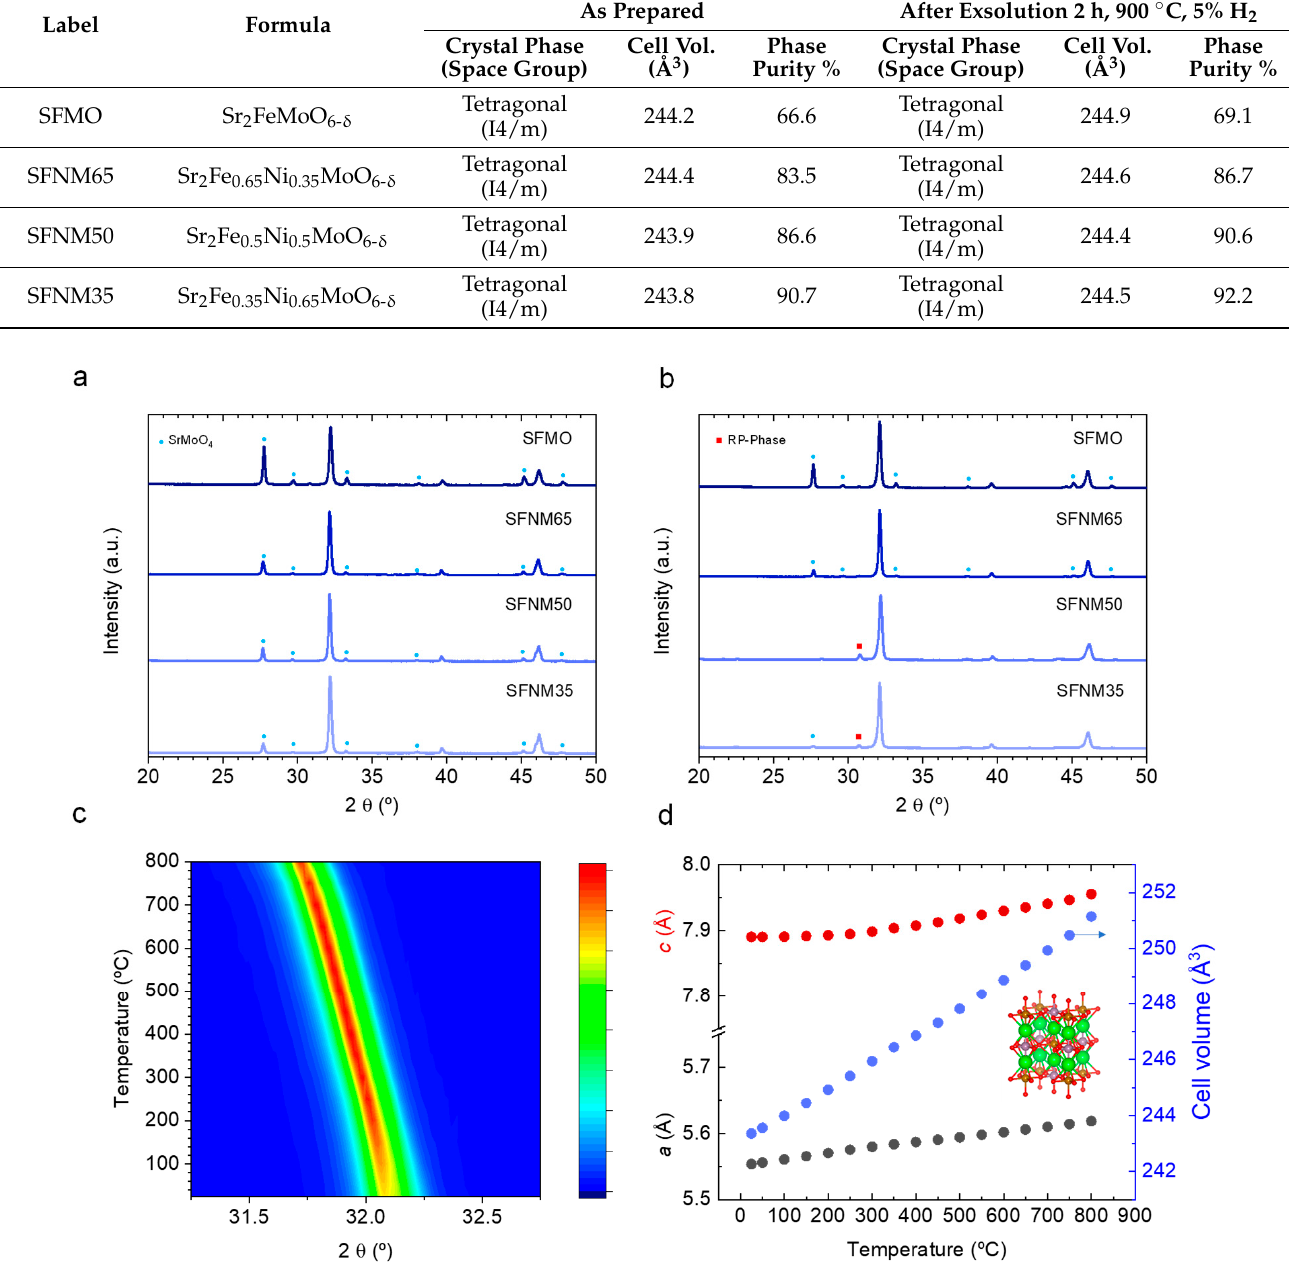
Table 1. Label, formula, and crystallographic data of the four Sr 2 Fe x Ni 1-x MoO 6- δ samples before and after exsolution.